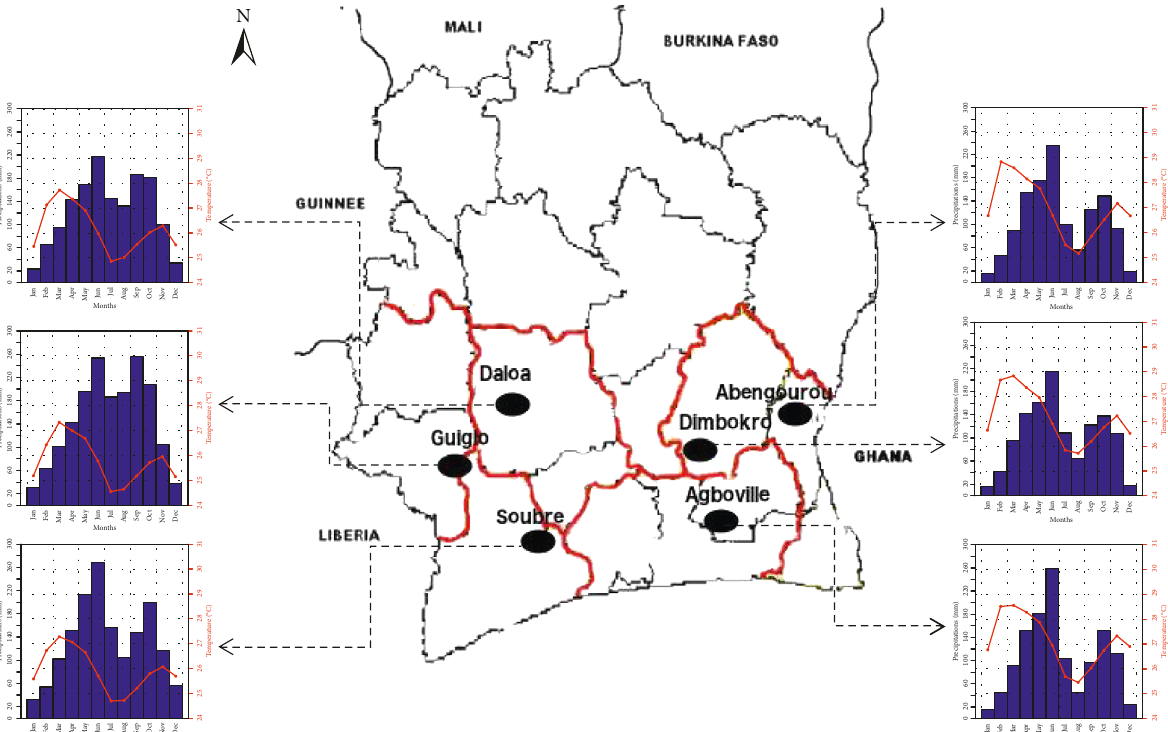
Figure 2: Study area with the six reference departments and their mean ombrothermal diagram over the 1989–2006 period. Red contours delimit the important areas of cocoa